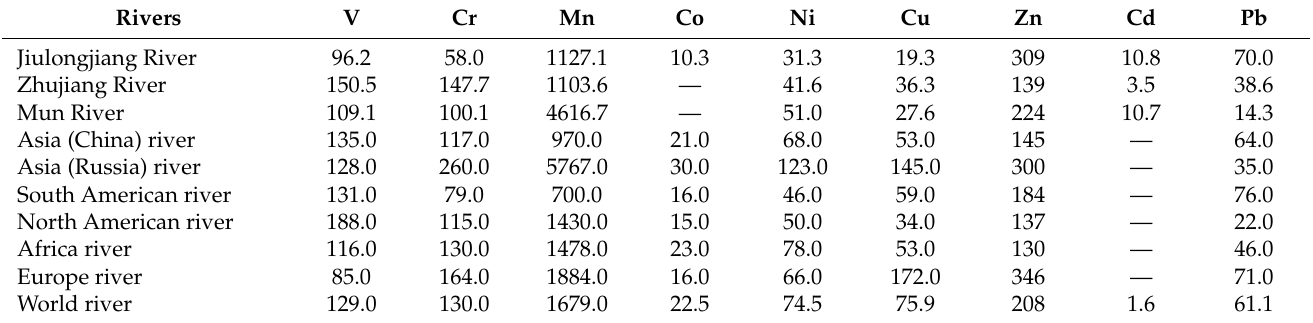
Table 2. The PTEs concentrations of SPM between JRB and global rivers (mg kg − 1 ).